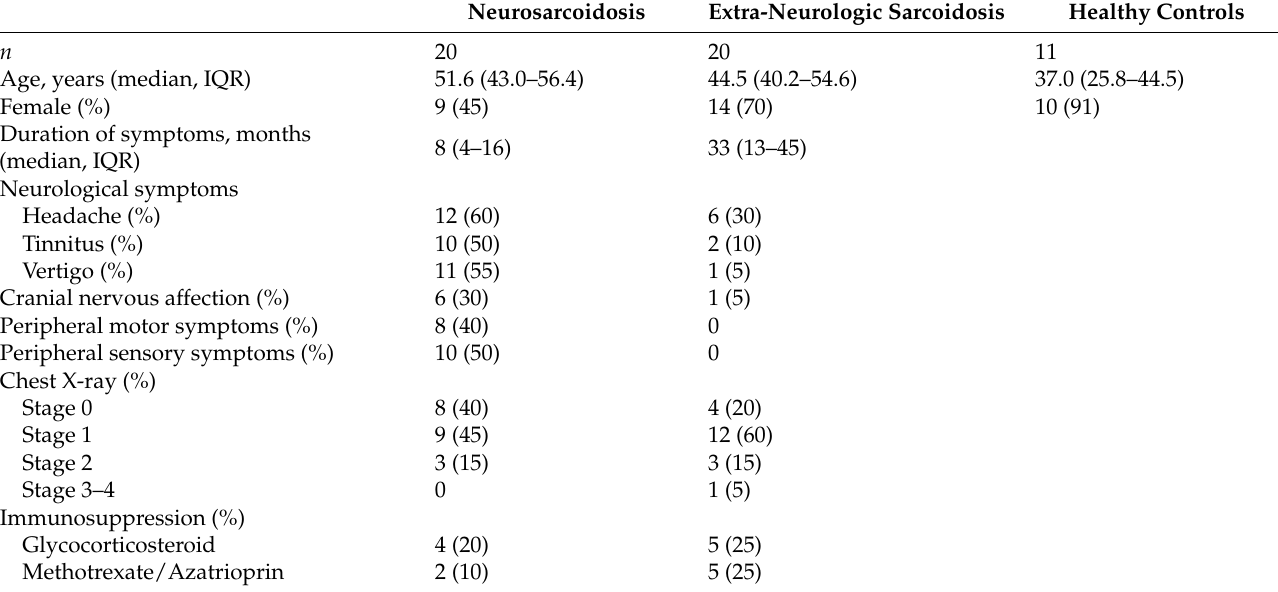
Table 1. Baseline characteristics in patients with neurosarcoidosis or extra-neurologic sarcoidosis, and healthy controls. Neurosarcoidosis Extra-Neurologic